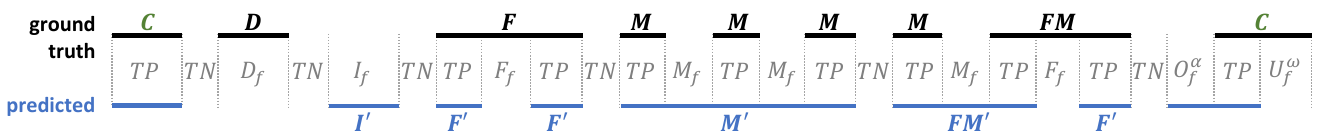
Figure 2. Example of segmented ground truth events and predicted events with annotations for event error and frame error classes. The vertical bars depict the segment boundaries. The frame error classes are given per